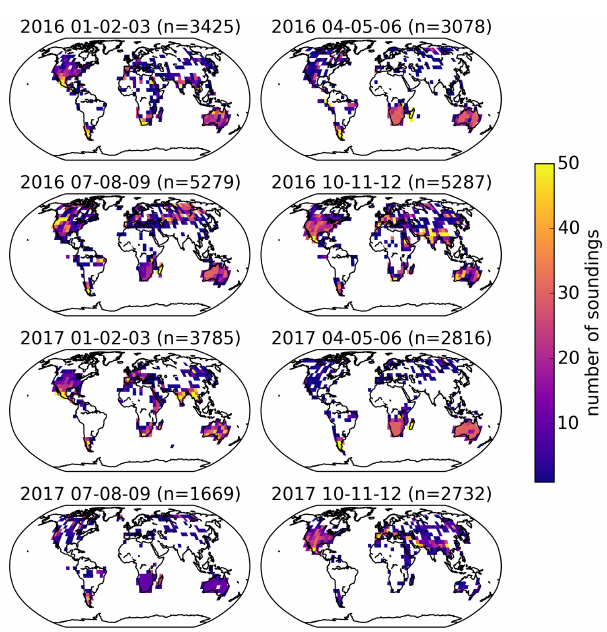
Figure 1. Spatial and temporal repartition of the sample of nadir OCO-2 soundings selected for 5AI retrievals, in seasonal and 5 ◦ × 5 ◦ square bins. The titles include n , the number of soundings for the corresponding panel. The low number of selected soundings in July–September 2017 is due to an identified OCO-2 data gap.